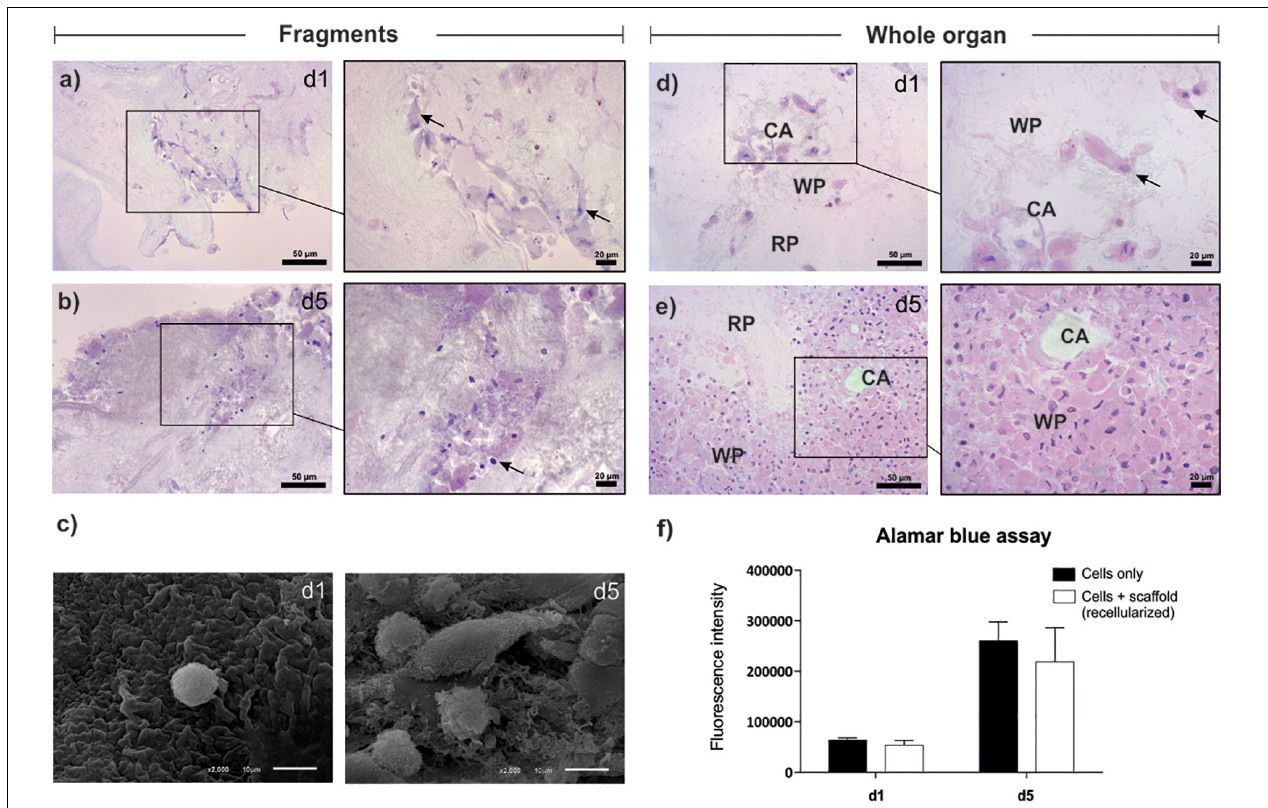
FIGURE 5 | Recellularization of the splenic scaffold. Representative images of hematoxylin and eosin (a,b) and SEM (c) showing the recellularized scaffold with stromal cells (arrows) by the method of direct cultivation on the ECM (fragments), on days 1 and 5 after seeding. (d,e) Representative images of hematoxylin and eosin (H&E) showing the recellularized scaffold with stromal cells by the perfusion method (whole organ), on days 1 and 5 after seeding. On day 5 the cells were located mainly in the white pulp region. (f) Viability and proliferation assay with Alamar blue, showing the difference in fluorescence intensity produced by the metabolically active cells in the control (cells only) and recellularized (cells + scaffold) groups, after 1 and 5 days of seeding ( n = 3/group). Abbreviations: day 1 (d1), day 5 (d5), recellularized White pulp (WP), decellularized Red pulp (RP); central artery duct of the white pulp (CA). Scale bars, H&E: 50 and 20 µ m; SEM: 10 µ